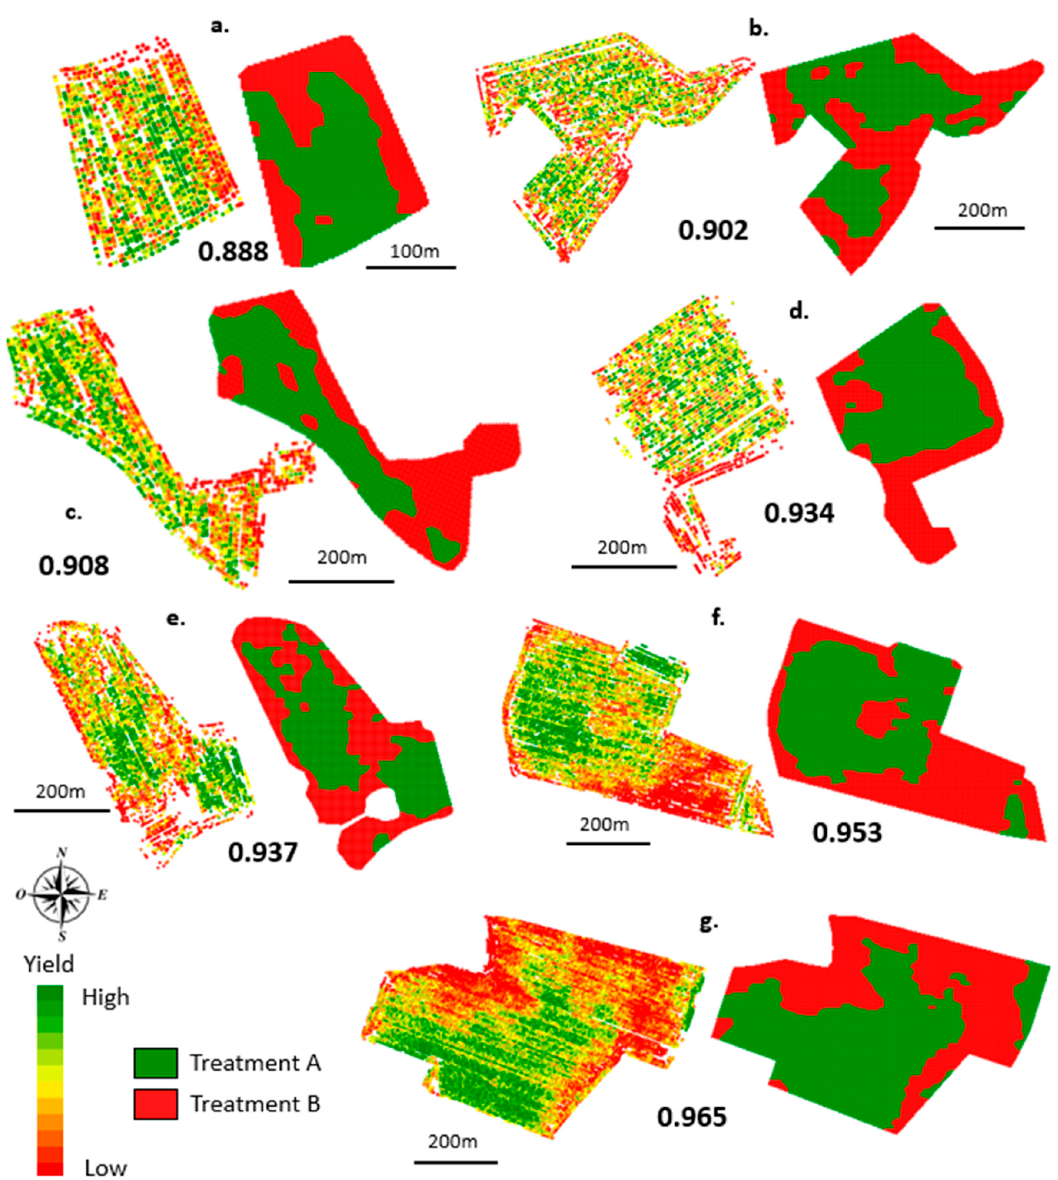
Figure 7. Screenshot of output from the computation of the Technical Opportunity Index (TOI) in GeoFIS for Field 7.